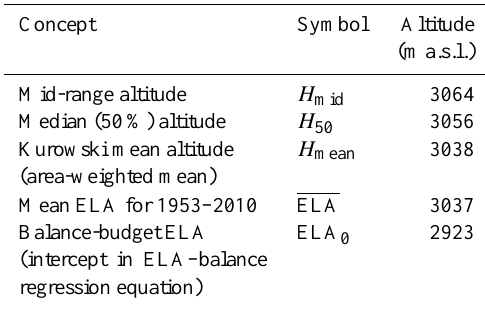
Figure 2. Year-to-year variations in equilibrium line altitude (ELA) at Hintereisferner, Austrian Alps, as measured in a surface mass- balance programme for 1953–2010. Gaps in the record after 2000 refer to years where ELA was above the maximum altitude of the glacier.